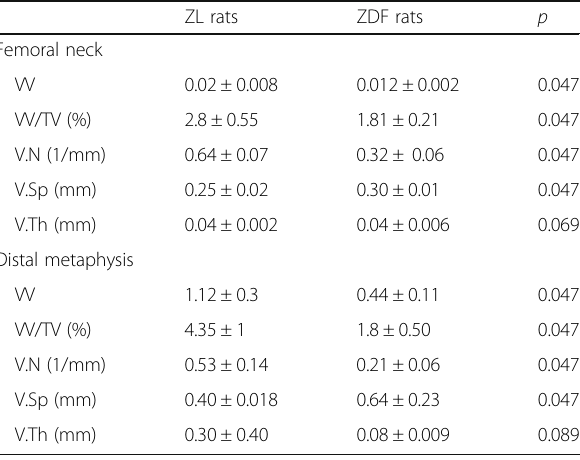
Table 2 Analysis of cortical bone